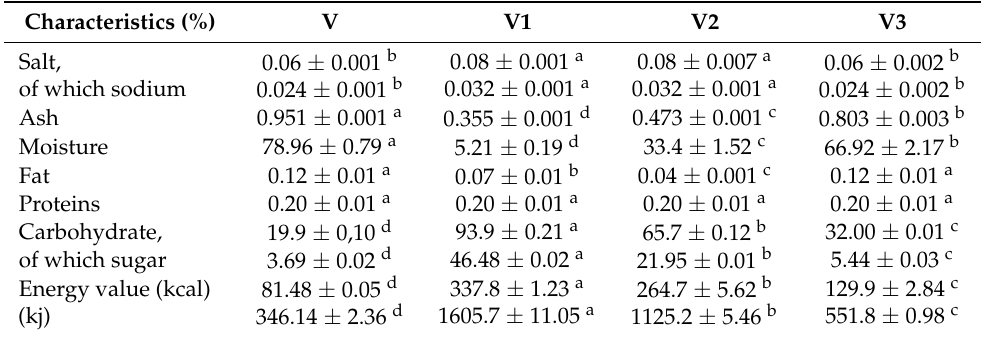
Table 5. The proximate analysis and caloric values of the jellified